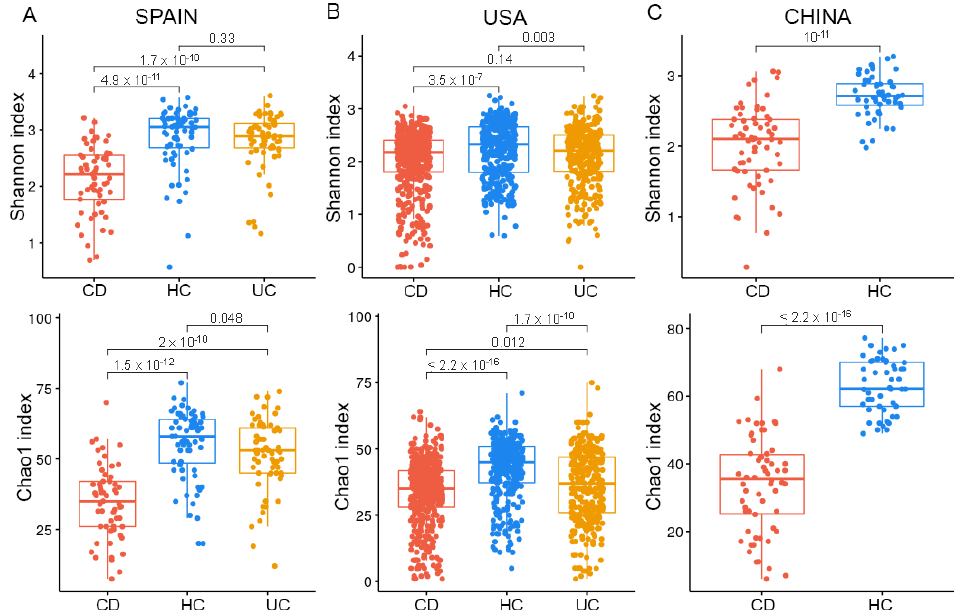
Figure 2. Alpha-diversity across cohorts. ( A ) In the Spanish cohort, Shannon and Chao1 indices showed a significant decrease in both microbial richness and evenness in CD. ( B ) In the USA cohort, the differences in Shannon and Chao1 indices were maintained when comparing CD with HC, but not when comparing CD with UC. ( C ) The Chinese cohort also showed decreased richness and evenness in CD compared with HC.